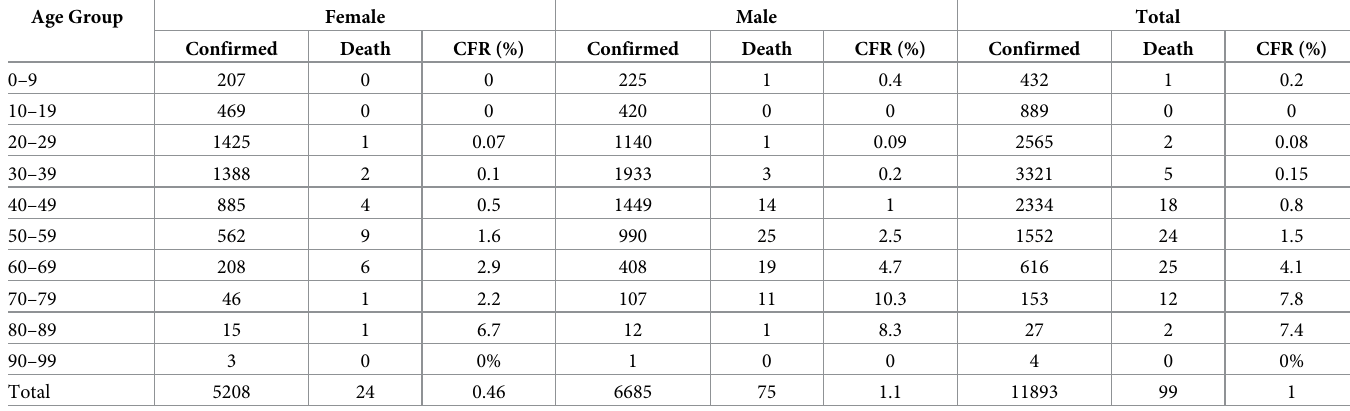
Table 2. Age-sex distribution of FCT COVID-19 confirmed cases and deaths, March 2020 -January 2021. Age